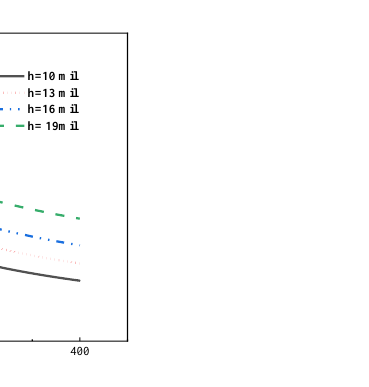
Fig. 11. Influence of the substrate cell density and wall thickness on the DPF load pressure drop under certain conditions.